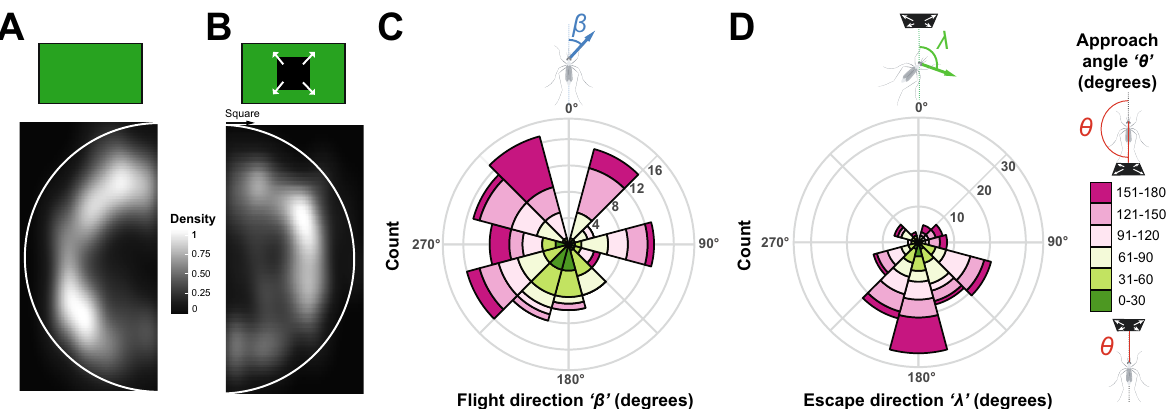
Figure 4. Overall behavioral responses to the looming square. (A,B) 2-D histogram of the locations occupied by mosquitoes within the LED arena. Data are mirrored on the vertical axis; the white semi-circles indicate the relative position of the arena’s walls. (A) Normalized histogram of the location of mosquitoes during randomly selected flight bouts, without visual stimulation. (B) Normalized histogram of the location of mosquitoes during the first 0.17 s (5 frames) after a take-off triggered by the introduction of a looming square. Data are oriented such that the stimulus introduction (indicated with a black arrow) is positioned at the top of the figure. (C) Rose diagram showing the circular distribution of the flight direction, β (i.e. , the direction of escape relative to the mosquito’s body orientation) within 0.17 s of stimulus-triggered take-offs. (D) Rose diagram showing the circular distribution of escape direction, λ (i.e. , the direction of escape relative to the stimulus) within 0.17 s of stimulus-triggered take-offs. ( C,D ) The length of the bars encodes for the number of observations, color-coded as a function of the approach angle, θ where 0° is to the front of the mosquito, and 180° is behind the mosquito (n = Fig. 5D,H, a β angle of 0° indicates a forward flying mosquito and 180° indicates a backward flying mosquito. In Fig. 5E,I, a λ of 0° indicate flying toward the stimulus and 180° away from the stimulus. These results show that mosquitoes escaped away from the looming stimulus, regardless of the approach angle, by flying away from the direction of the stimulus. Remarkably, take-offs were even observed even for stimulus introductions immediately behind the mos- quito (135°–180° angles), highlighting landed mosquitoes’ capacity to detect threats coming from all directions along the azimuth. Finally, analyzing the response latency of mosquitoes, we found that the time taken by the mosquitoes to take off in response to stimulus introduction was not influenced by the approach angle θ of the stimulus and mosquitoes’ distance to the stimulus. The response latency of the 142 escape responses observed in this study typically ranged between 0 and 0.53 s and was non-normally distributed (Fig. 6; Shapiro–Wilk test;